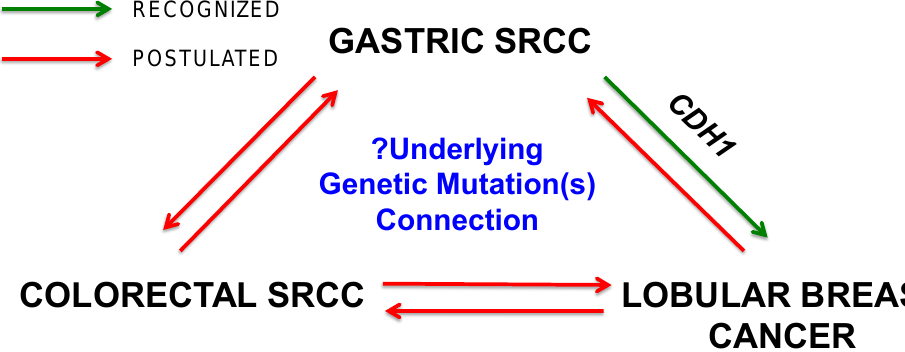
Figure 2. Postulated interrelationship between gastric, colorectal, and lobular breast cancers. The link between gastric SRCC and lobular breast cancer is recognized in CDH1 germline mutation patients. Our speculative results from sporadic gastric, colorectal, and lobular breast cancer patients (Tables 5 – 7) postulate the existence of bidirectional relationships across all three cancer subtypes that warrant further investigations.